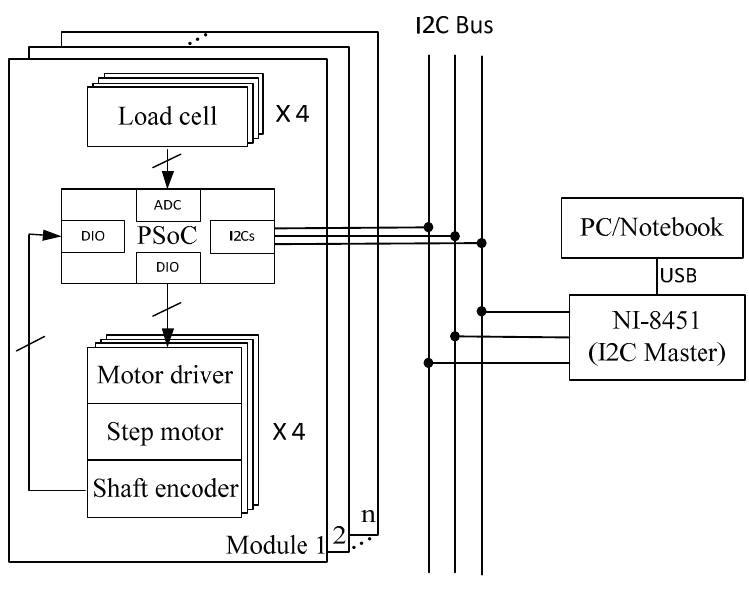
Figure 4. The structure of the electronic